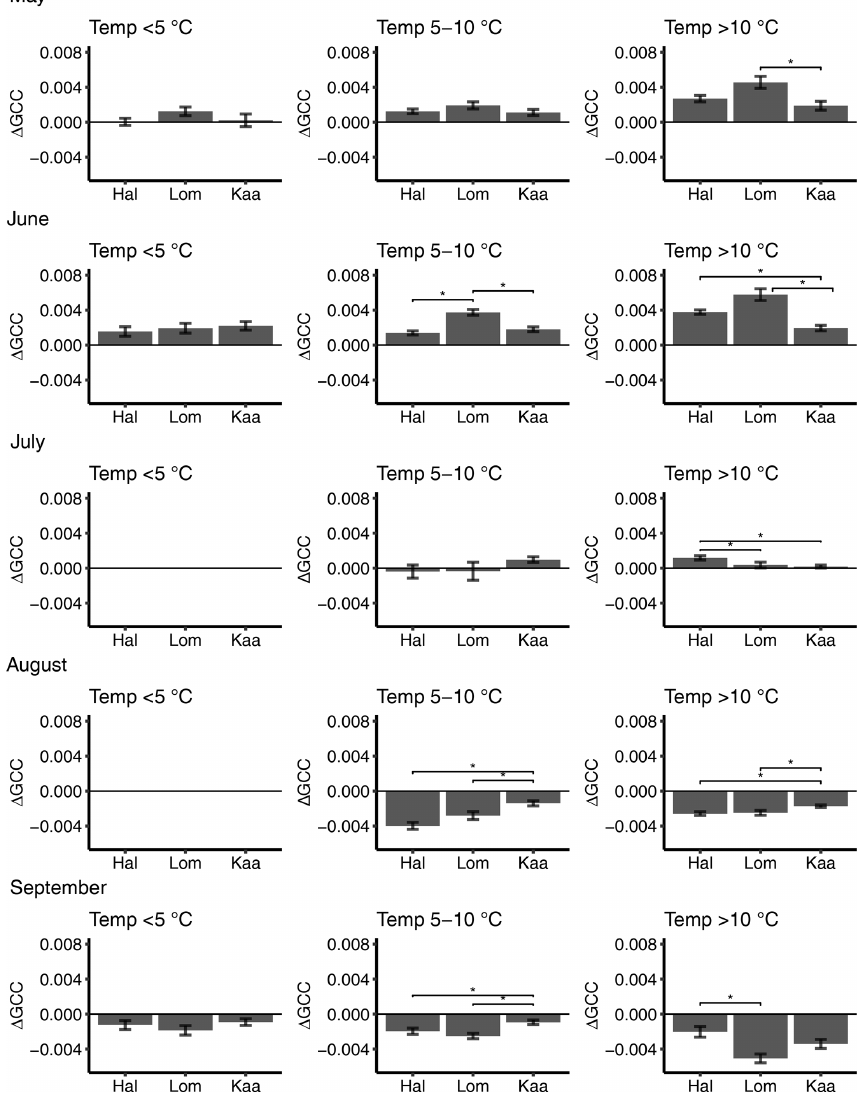
Figure 6. Mean 3d difference in GCC divided into temperature classes ( < 5, 5–10, > 10 ◦ C) at Halssiaapa (Hal), Lompolojänkkä (Lom) and Kaamanen (Kaa) from May to September. There are no temperature data in the < 5 ◦ C class in July and August. The error bars denote the standard error, and the asterisks denote the statistically significant ( p < 0 . 05) difference between the